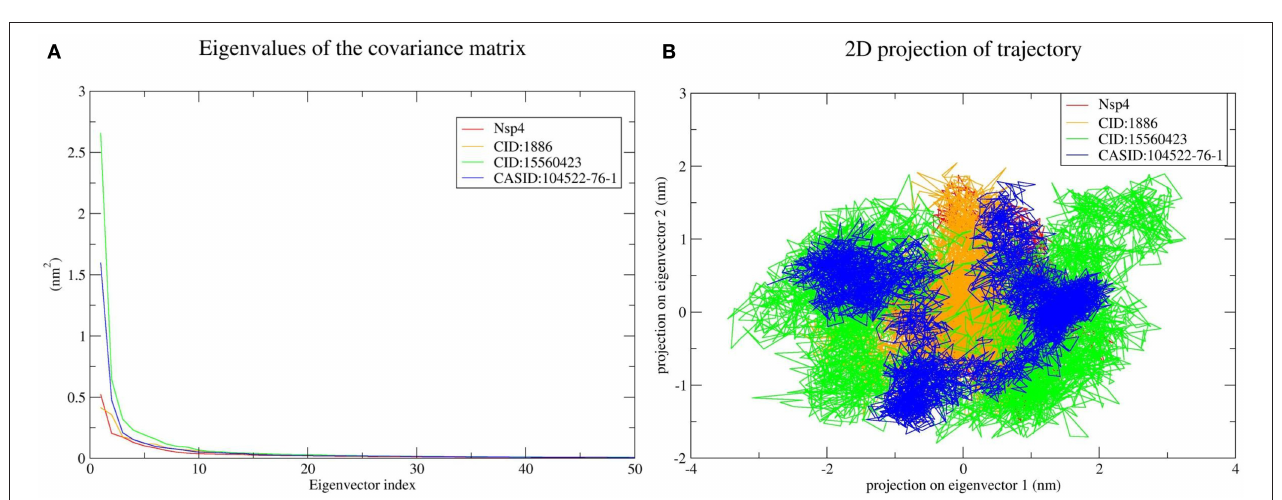
FIGURE 7 | Principal component analysis of Nsp4 and the Nsp4-phytochemical complexes. (A) Plots of eigenvalues vs. the first 50 eigenvectors derived from the final 50 ns of MD simulations. (B) The first two eigenvectors representing the motion of Nsp4 and its complexes in phase space. Red, orange, green, and blue colors represent Nsp4, Nsp4-CID:1886, Nsp4-CID:15560423, and Nsp4-CASID:104522-76-1,